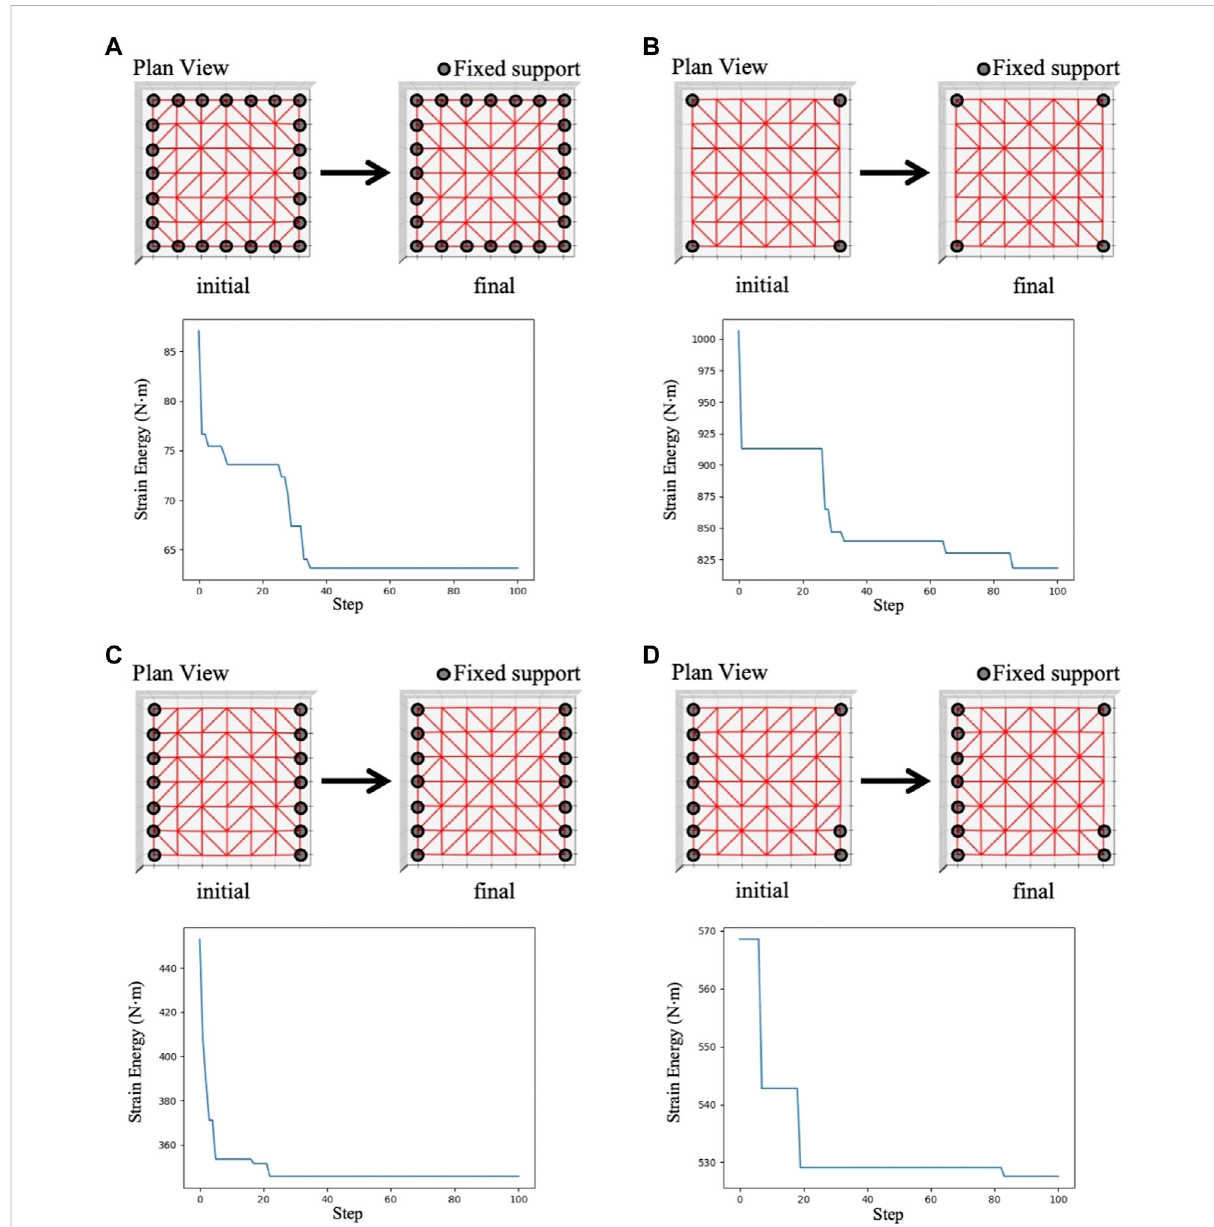
FIGURE 11 GCN-DDPG result of the 6×6-grid structure in the test phase; (A) Support condition 1, (B) Support condition 2, (C) Support condition 3, (D) Support condition